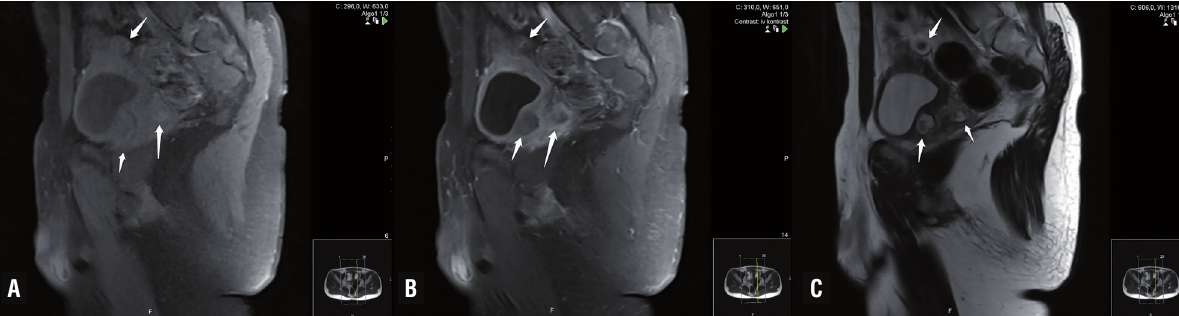
3 - Mri sagittal images; nodular lesions marked with arrows a. t1 weighted fat suppressed B. post contrast t1 weighted fat suppressed c. t2 weighted